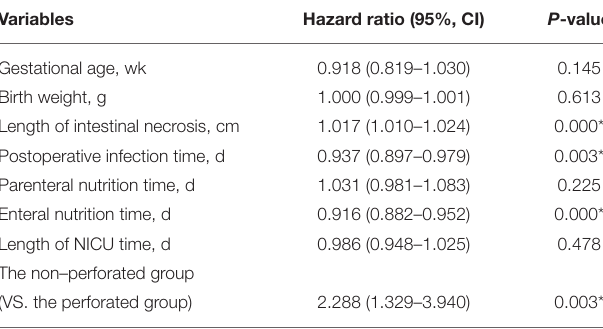
TABLE 4 | Multivariate proportional hazards analysis for survival at 30